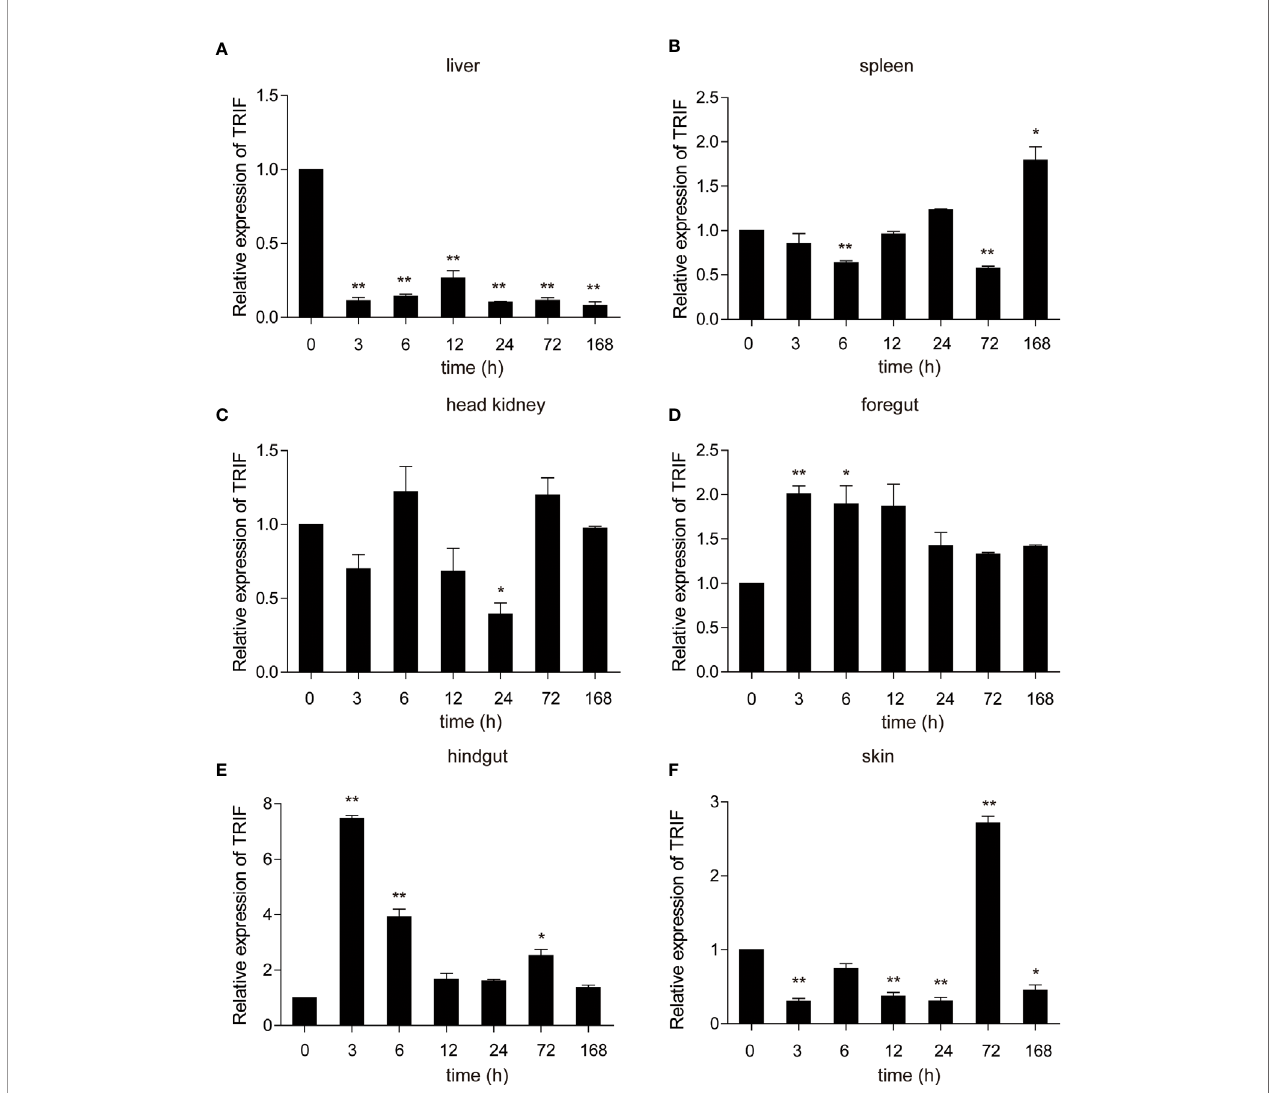
FIGURE 4 | The relative expression of carp TRIF in various tissues of common carp after intraperitoneal injection with A. hydrophila . The expression of carp TRIF in the liver (A) , spleen (B) , head kidney (C) , foregut (D) , hindgut (E) , and skin (F) at different time points are shown. The results were calculated relative to the expression of the 40S ribosomal protein s11. Data were presented as a fold increase compared to the unstimulated control group (denoted by 0 h). Means ± SD (n = 3), * P < 0.05, ** P <